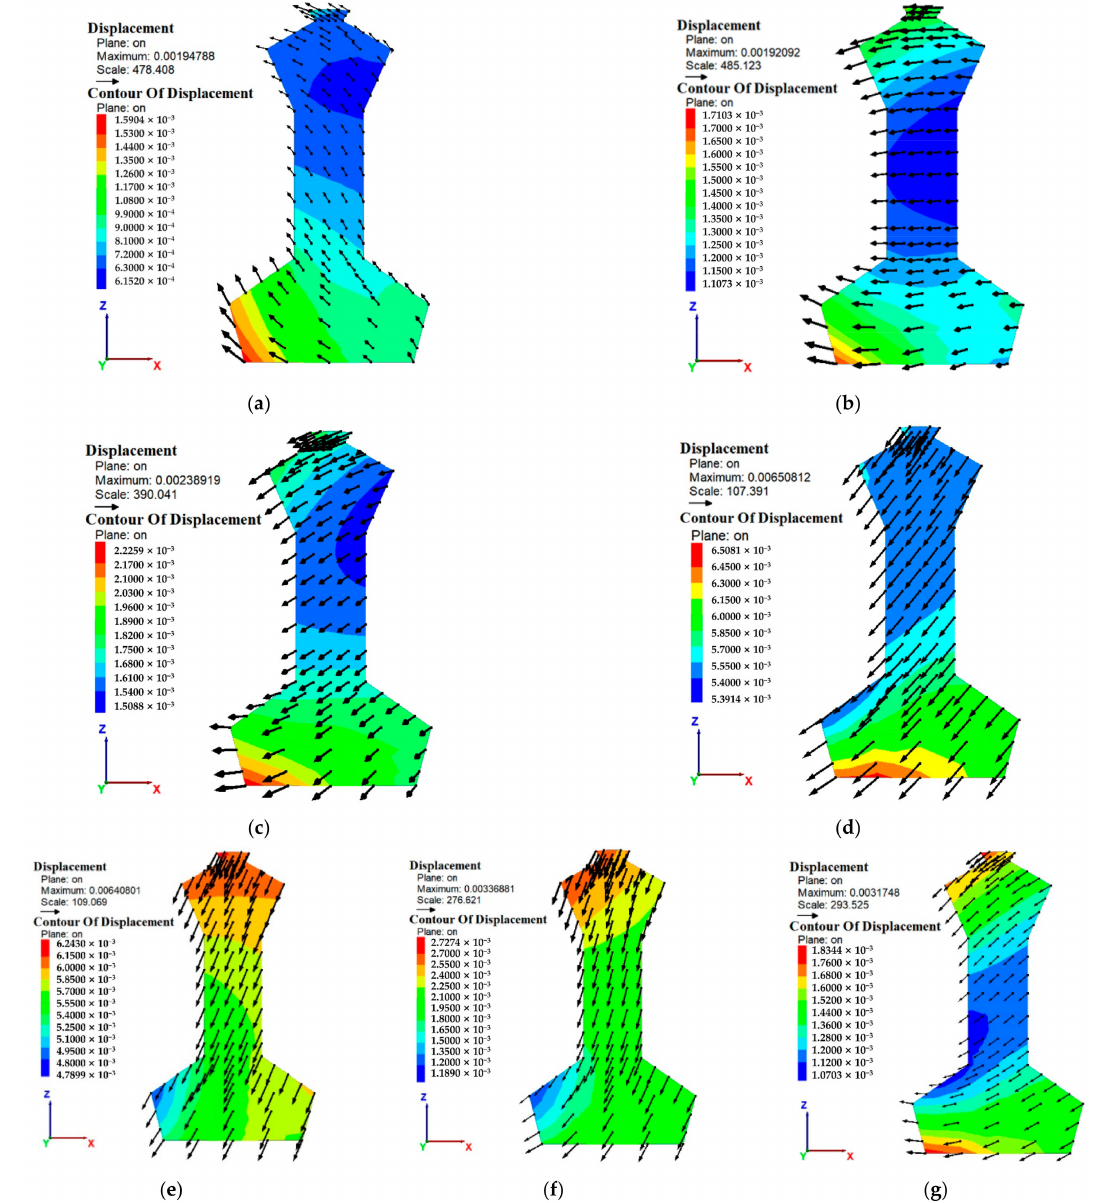
Figure 20. Displacement of middle partition wall at different sections (unit: m): ( a ) Y = 20 m; ( b ) Y = 40 m; ( c ) Y = 60 m; ( d ) Y = 80 m; ( e ) Y = 100 m; ( f ) Y = 120 m; ( g ) Y = 140